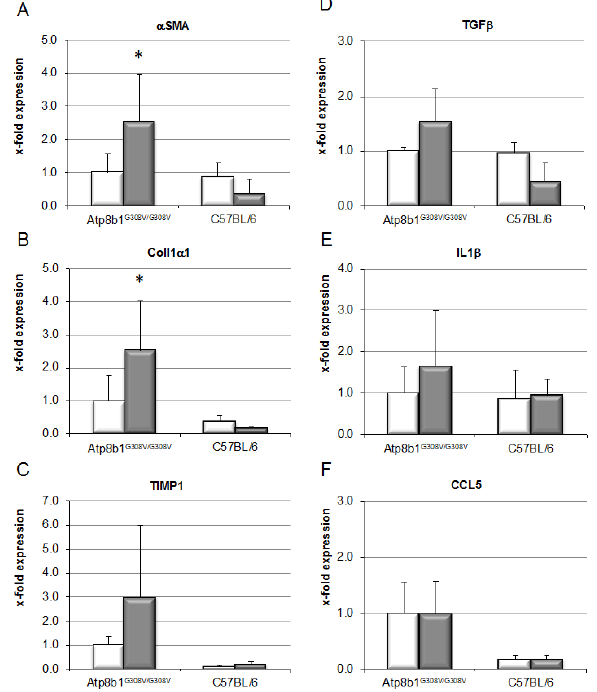
Figure 2. Chronic cholestasis in Atp8b1 G308V / G308V mice leads to pro-fibrotic gene expression only in the presence of GCDCA. Atp8b1 G308V / G308V and wild-type mice (C57BL / 6) were fed a standard diet (white bars) or a CA (0.1% w / w )- plus GCDCA (0.3% w / w )-enriched diet (grey bars) to induce cholestasis and a humanized bile salt pool for 8 weeks. Quantitative RT-PCR was performed for the indicated genes relative to the house-keeping gene GAPDH. Normalized values are shown as mean ± standard deviation ( n = 4 for C57BL / 6 and n = 7 for Atp8b1 G308V / G308V , * p < 0.05, Kruskall–Wallis